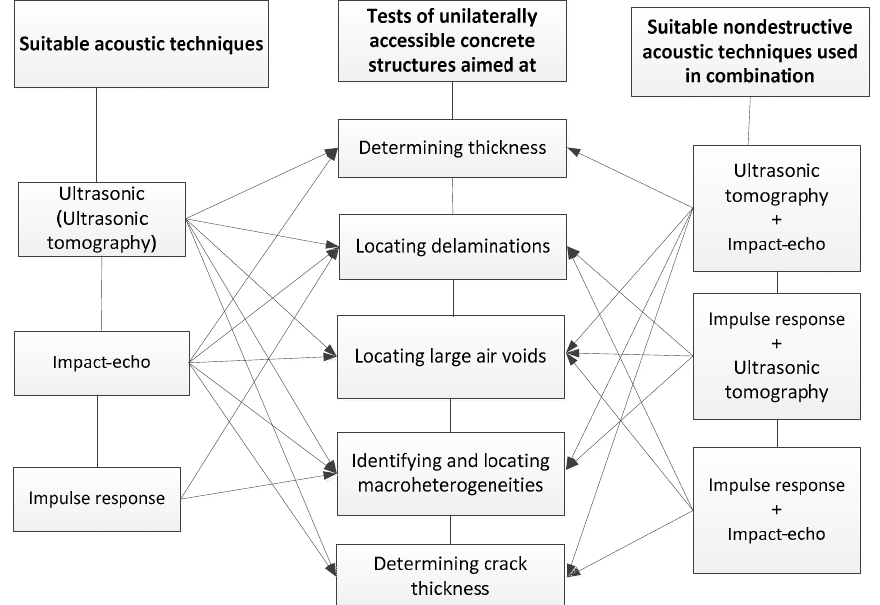
Figure 5. Suitability of state-of-the-art non-destructive acoustic methods, used individually or combined for testing concrete materials and structures [1].